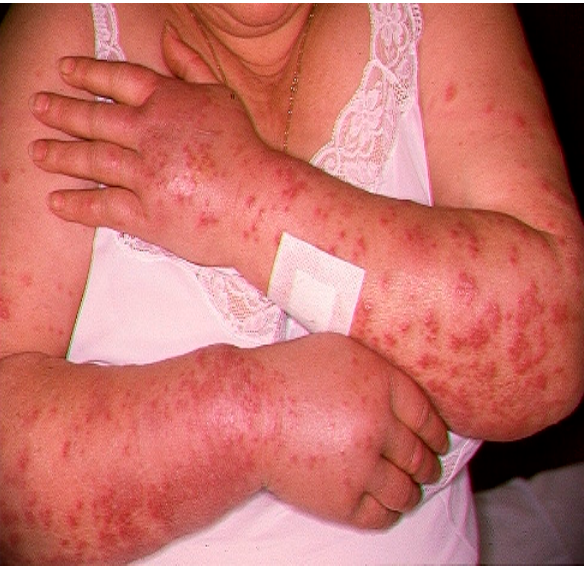
Figure 1. Papulonodular manifestations in our patient, following therapy with hydroxychloroquine (HCQ) (400 mg/day).